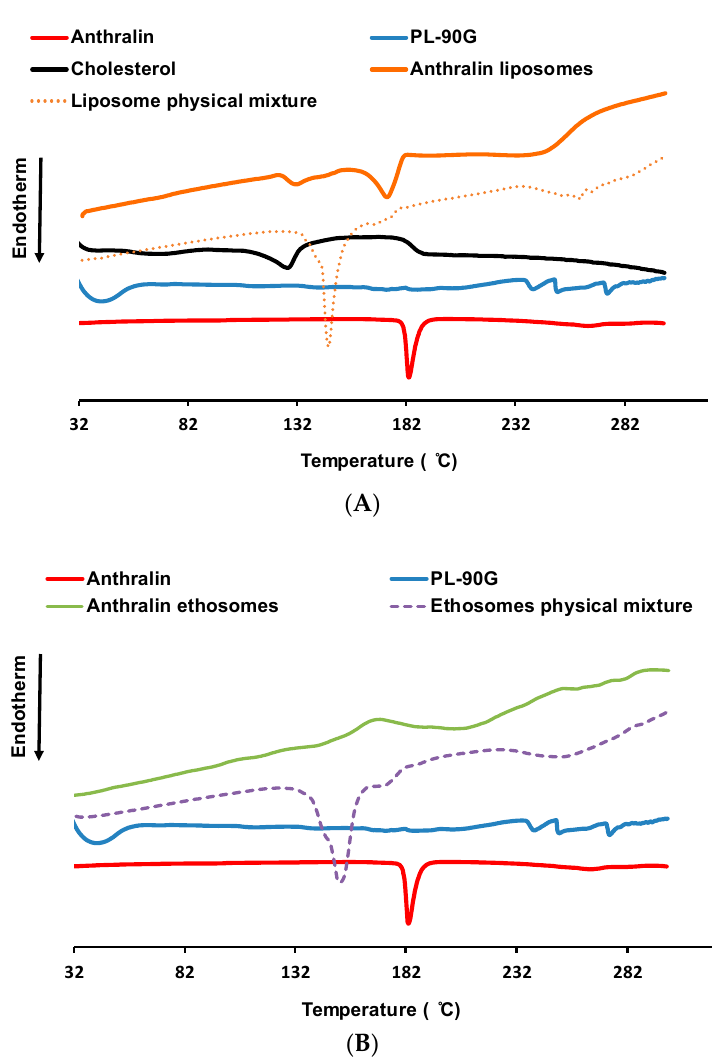
Figure 2. ( A ): Differential scanning calorimetry (DSC) thermograms of anthralin, PL-90G, cholesterol, liposome physical mixture and anthralin liposomes (L5). ( B ): DSC thermograms of anthralin, PL-90G, ethosome physical mixture, and anthralin ethosomes (E4).